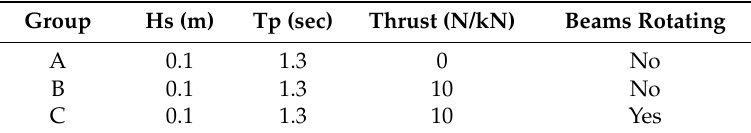
Table 1. Test matrix. All values are in model